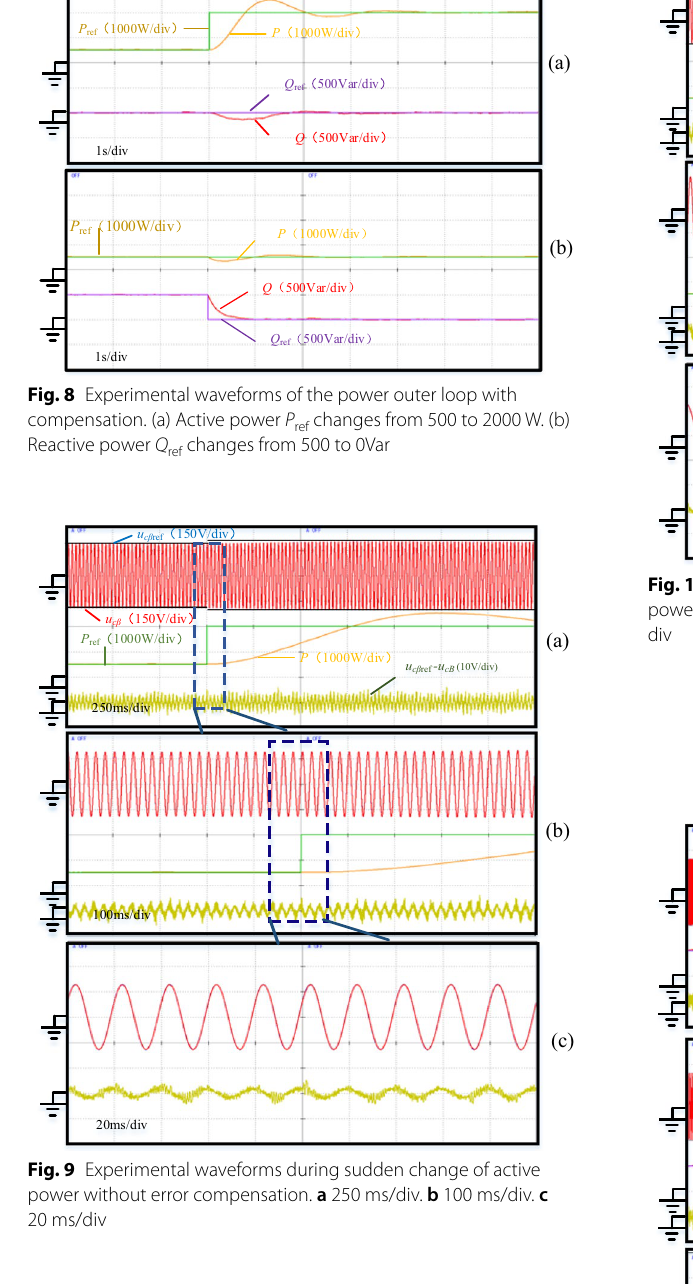
methods are almost identical in both dynamic and steady states. Similarly, further experimental waveforms during reac- tive power change for the two methods are compared in Figs. 11 and 12. As seen there, when the reactive power changes suddenly from 500 to 0 Var, the β-axis voltage values are reduced, while the waveforms corresponding to the two methods are almost identical.